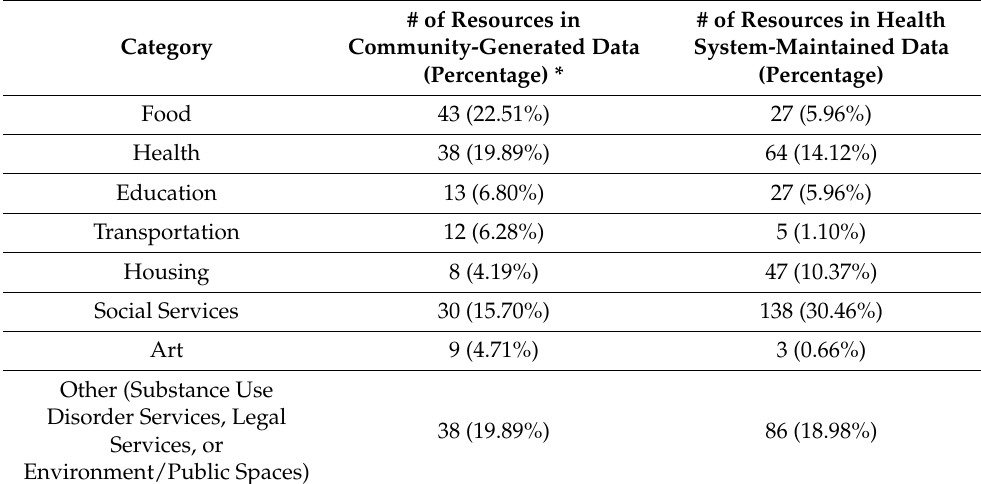
Table 3. Analysis of Community-Generated and Health System-Maintained Resource